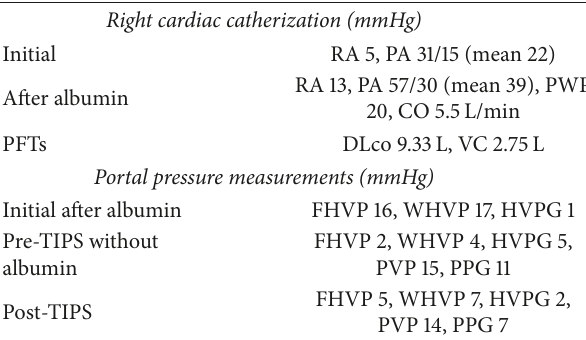
Table 1: Cardiac and portal pressure measurements.